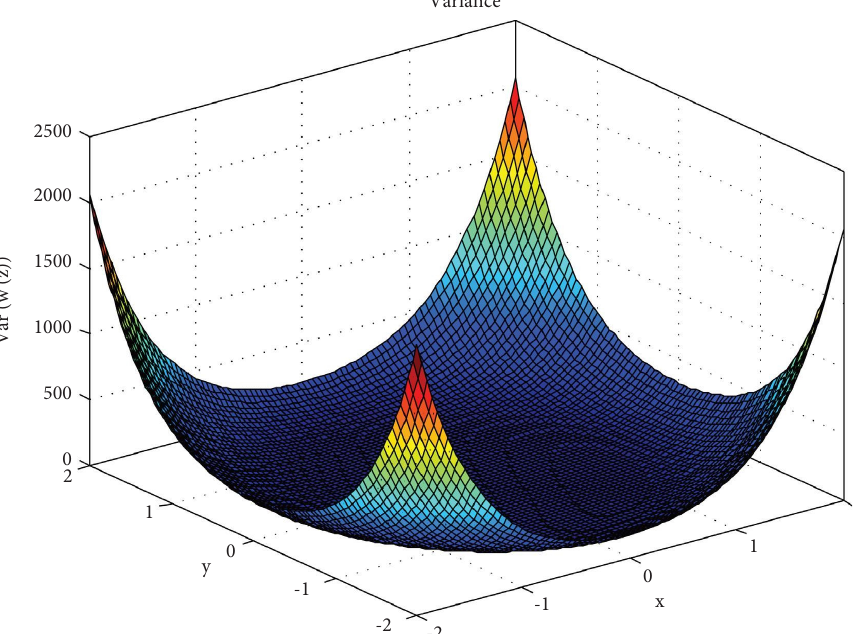
Figure 2: Variance of equation (17) for α � 1 , β �